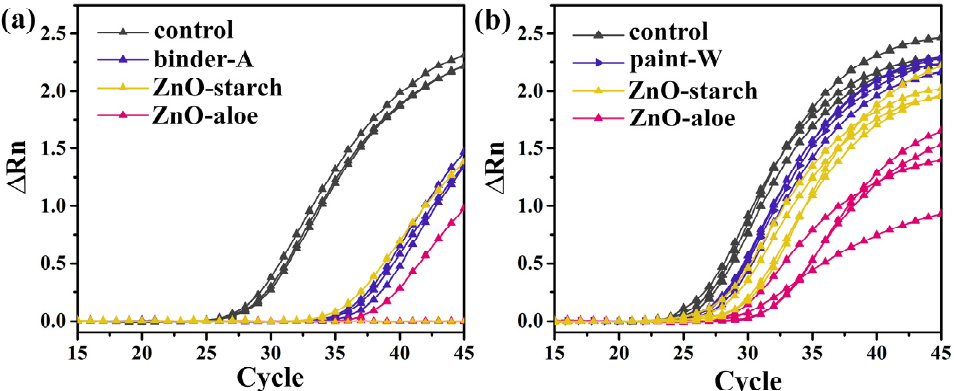
Table 1. Decrease of viral load of samples and controls after 24 h of exposure determined by RT- qPCR.